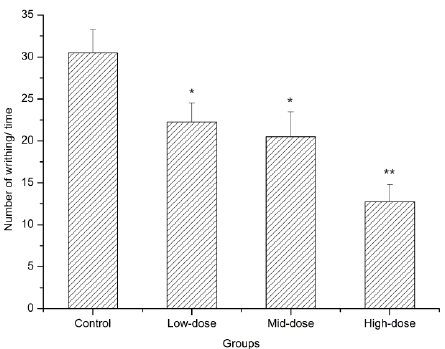
Figure 5. The effects of wICM on mice in acetic acid writhing test. Data are expressed as the means ± SD. * shows p < 0.05 compared with the control group; ** shows p < 0.01 compared with the control group.